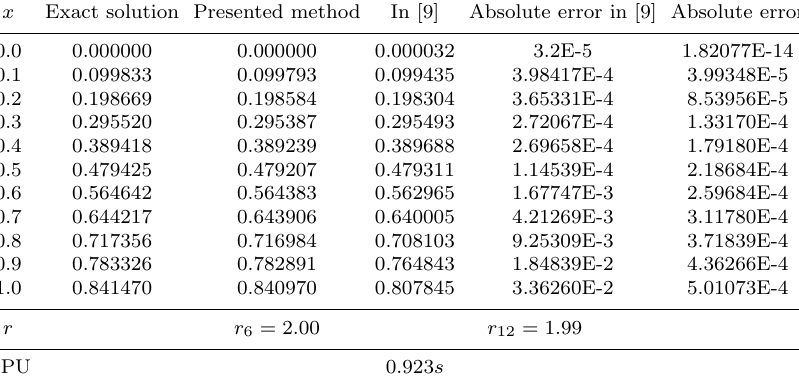
Table 2. Numerical result and absolute error for Example 2. x Exact solution Presented method